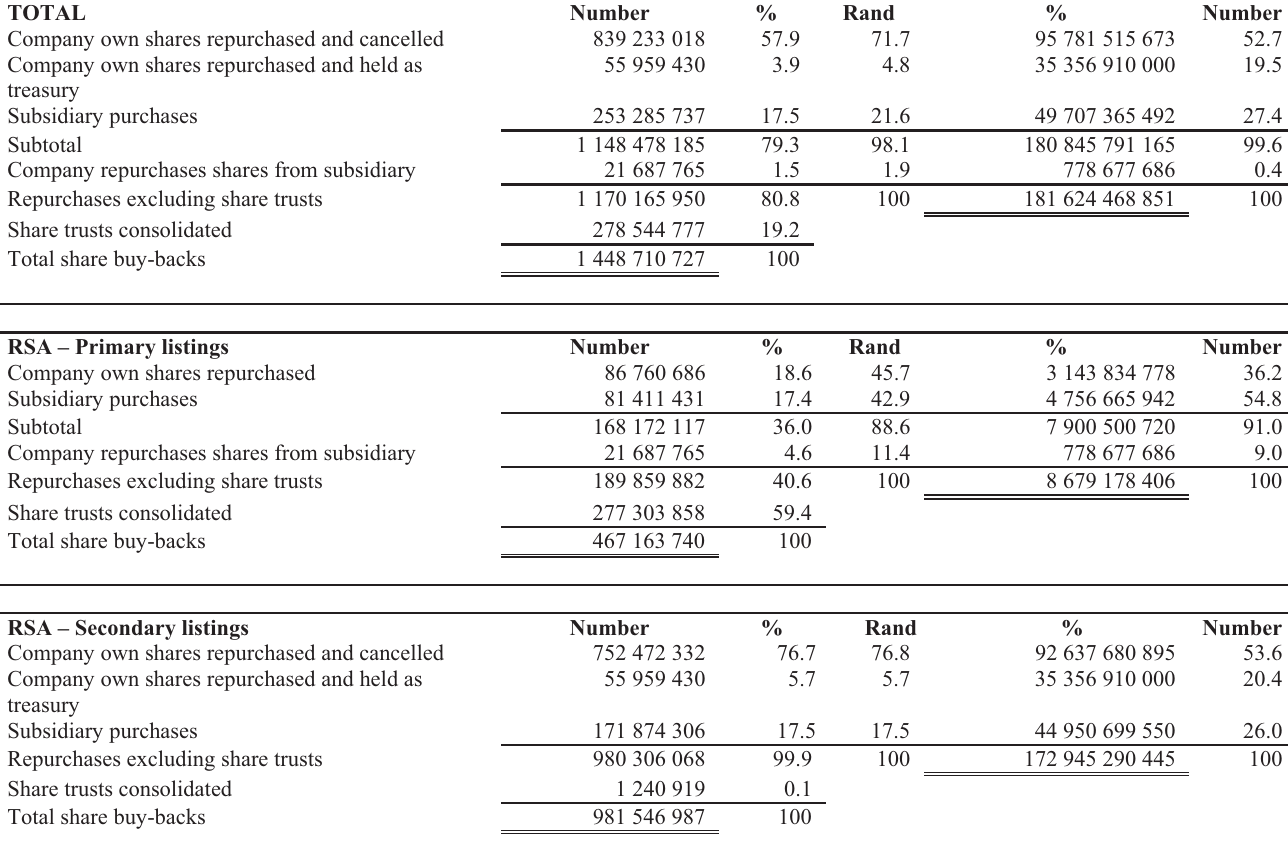
Table 4: Share buy backs by repurchasing entity